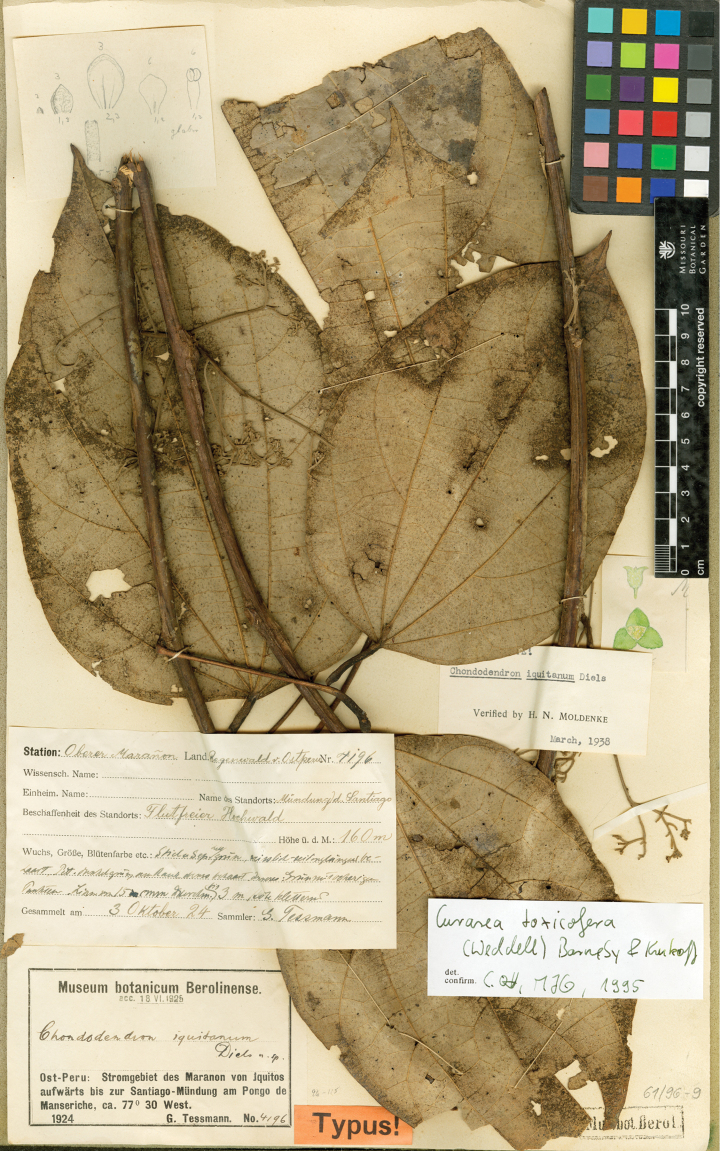

Curarea
iquitana (photograph of the type of Chondrodendron
iquitanum, Tessmann 4196, B).